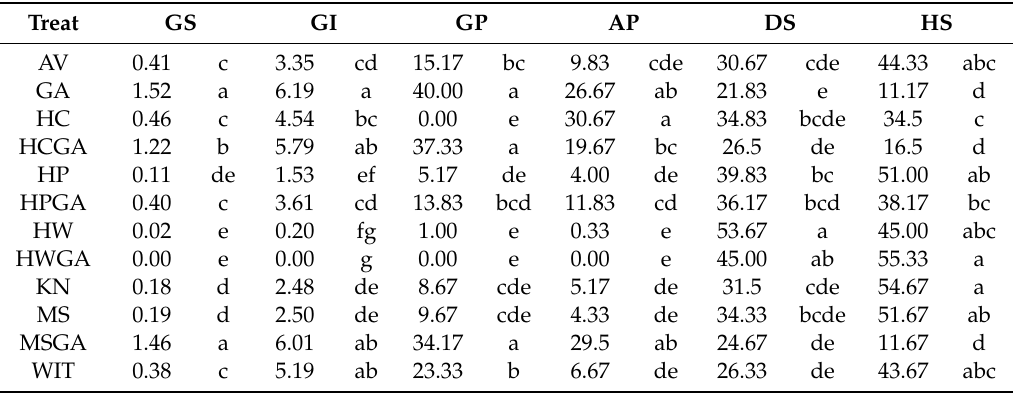
Table 4. Comparison of Tukey’s means ( p > 0.05) for pre-germinative treatments in physiological variables.